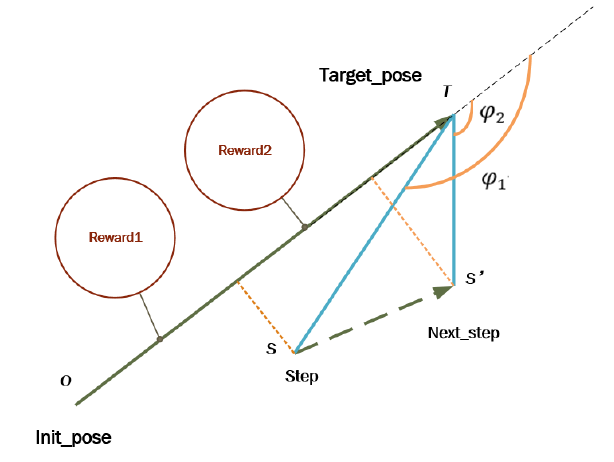
Figure 1. Calculation diagram of step-by-step reward